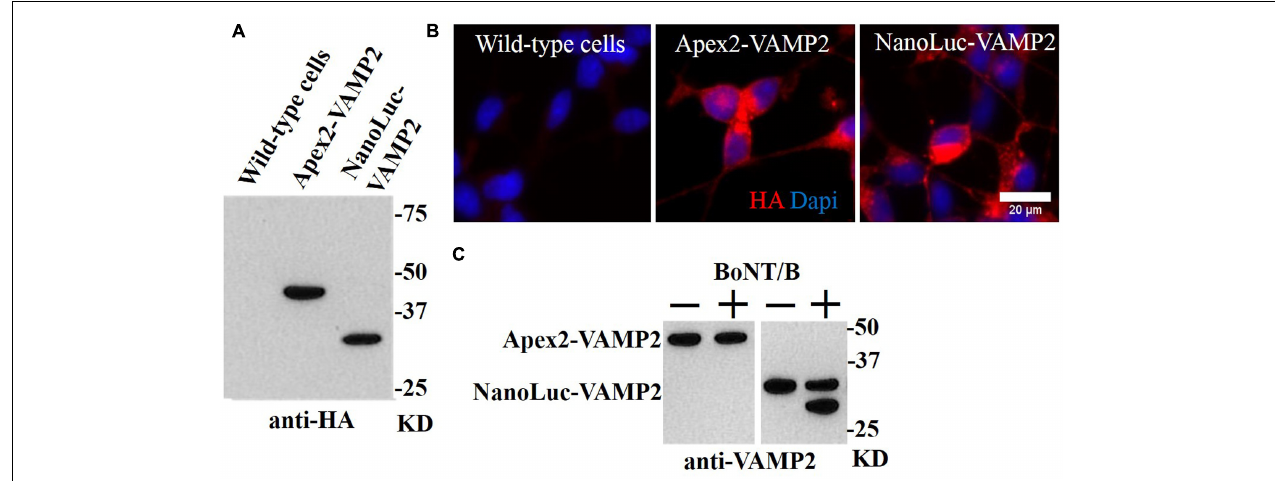
FIGURE 3 | Generation of stable SiMa cell lines with VAMP2 fusions to peroxidase APEX2 and luciferase NanoLuc. (A) Immunoblot showing expression of APEX2- and NanoLuc-VAMP2 constructs in SiMa cells with expected molecular weights of ∼ 45 kD and ∼ 30 kD. Both constructs carry the HA tag as evidenced by immunoblotting. (B) The fusion proteins exhibit robust expression as revealed by immunocytochemical analysis using antibodies against the HA-tag. (C) Immunoblot demonstrating that the APEX2-VAMP2 reporter molecule is resistant to cleavage by BoNT/B (10 nM), whereas VAMP cleavage is detectable in the differentiated NanoLuc-VAMP2 cells. The arrow indicates the cleaved